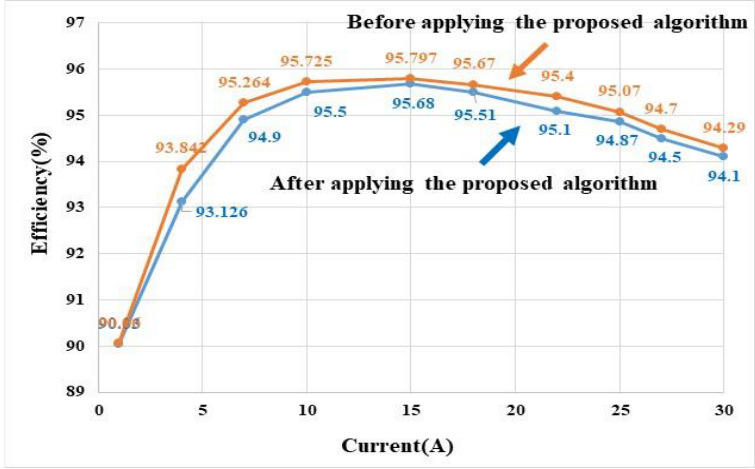
Figure 21. The battery charging current flow when determining fault module.